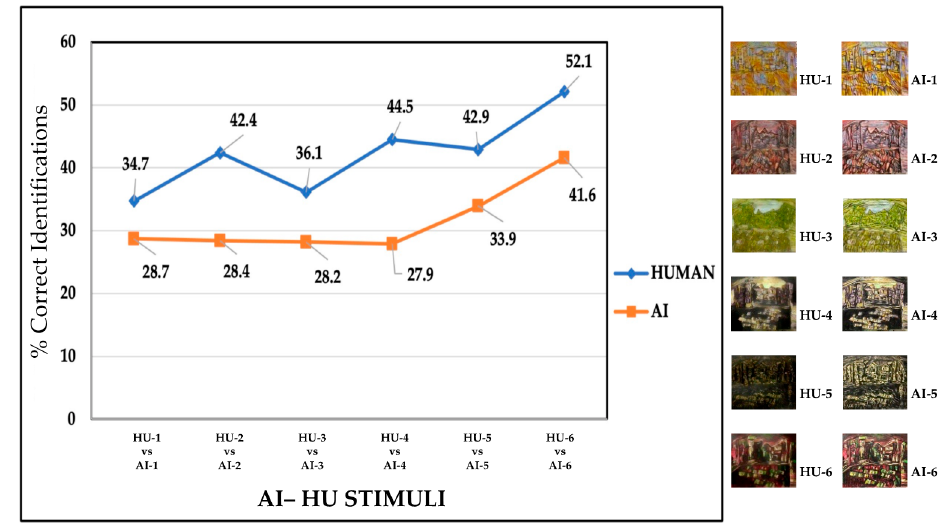
Figure 4. The percentage of participants who correctly judged each painting as either AI or human.